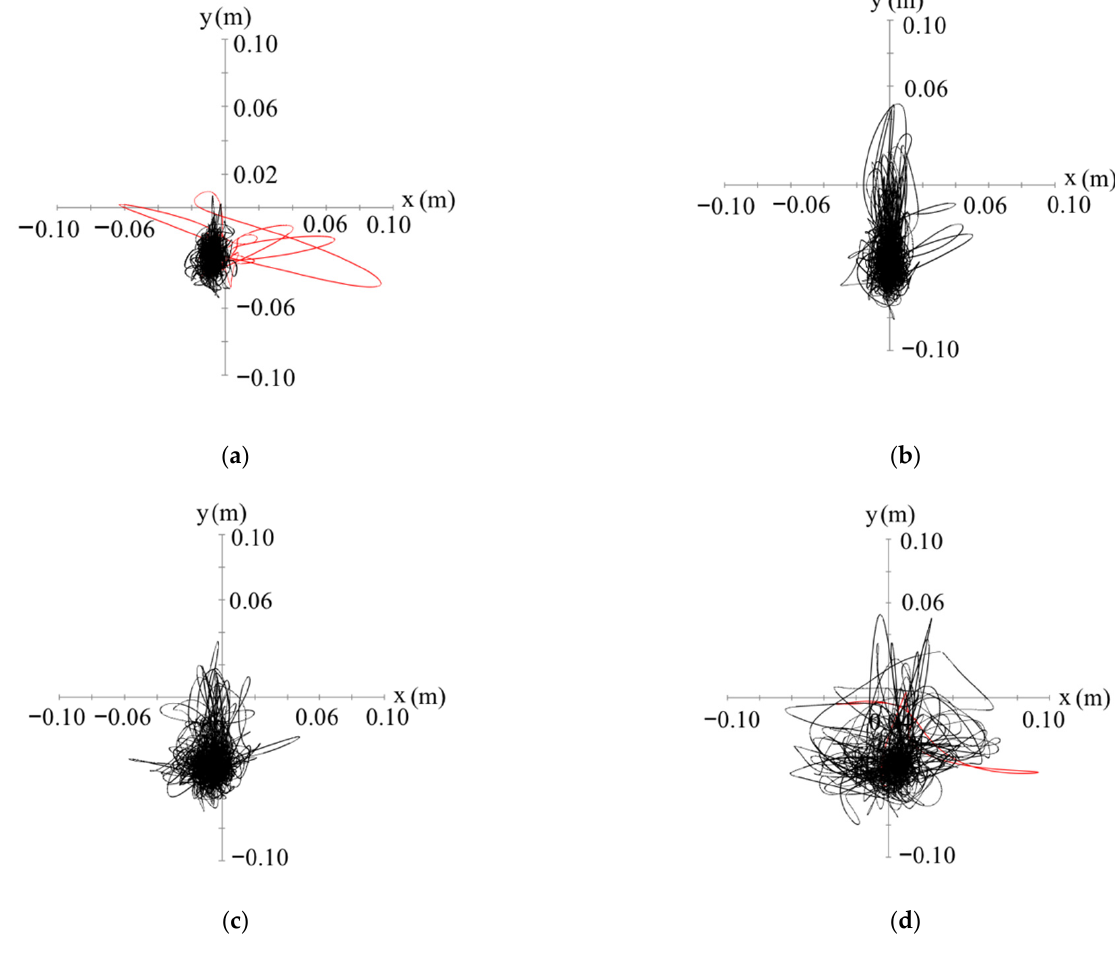
Figure 7. Example of the center of pressure (COP) locus (participant D): ( a ) Pattern 1; ( b ) Pattern 2 (wave direction: 180°); ( c ) Pattern 3 (wave direction: 135°); ( d ) Pattern 4 (wave direction: 90°).